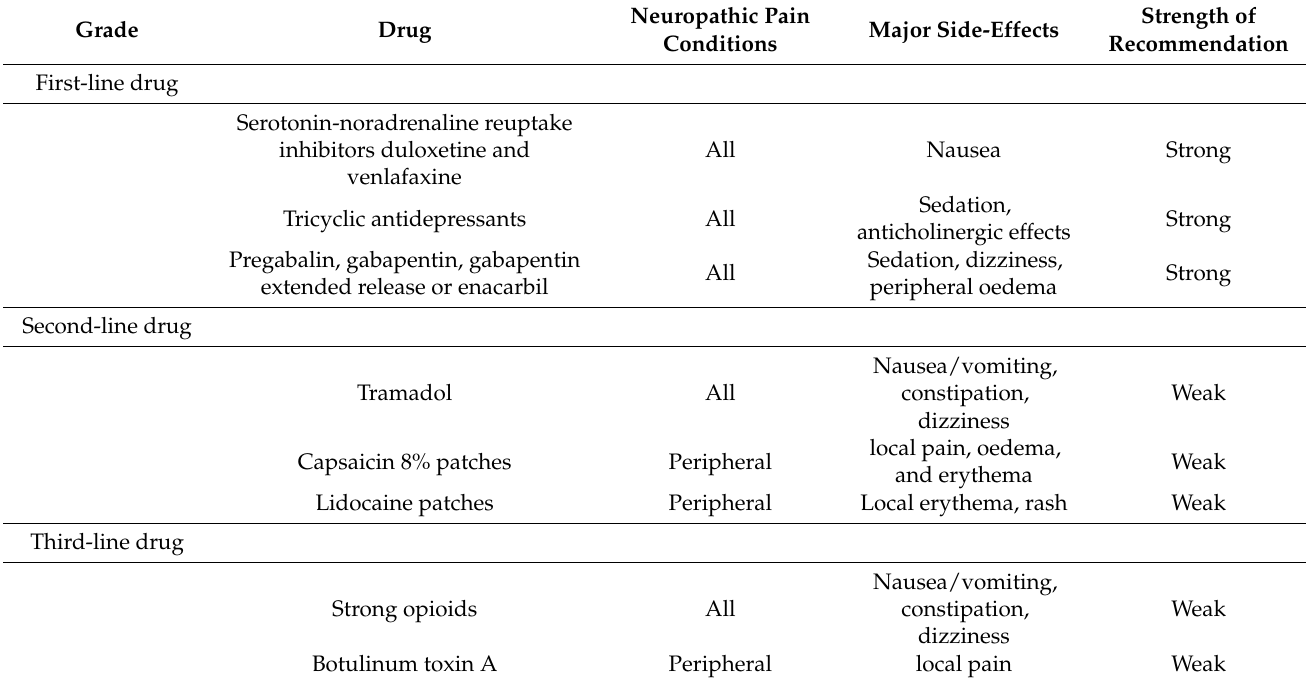
Table 1. Recommended drugs for the treatment of neuropathic pain based on the GRADE